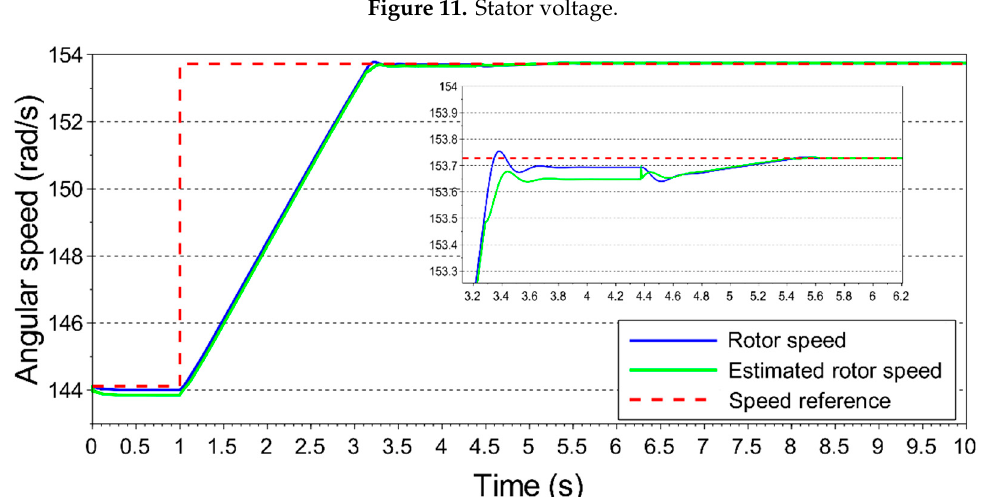
Figure 11. Stator voltage.